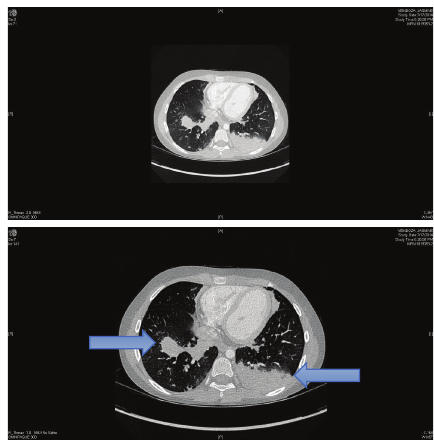
Figure 1: Chest CT, axial view with multifocal